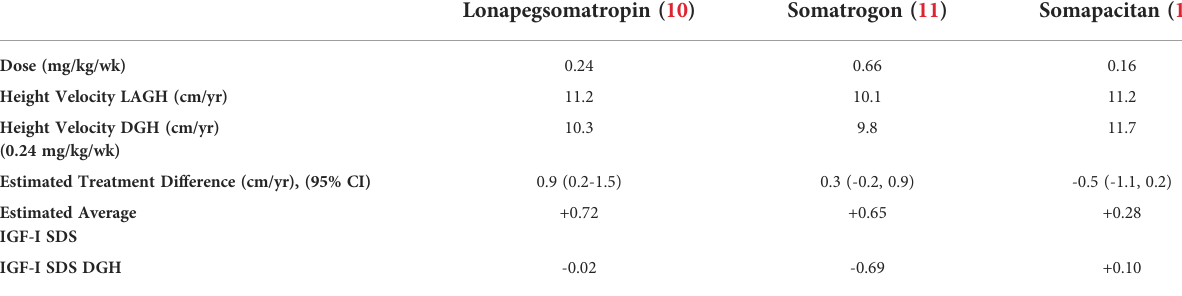
TABLE 2 Long-acting growth hormone treatment response at 52